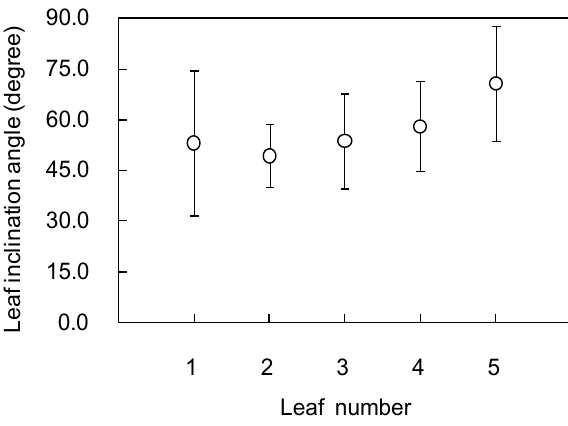
Figure 8. Leaf inclination angles estimated from polygon images of five leaves. White circles and error bars are mean and standard deviation values of each leaf,